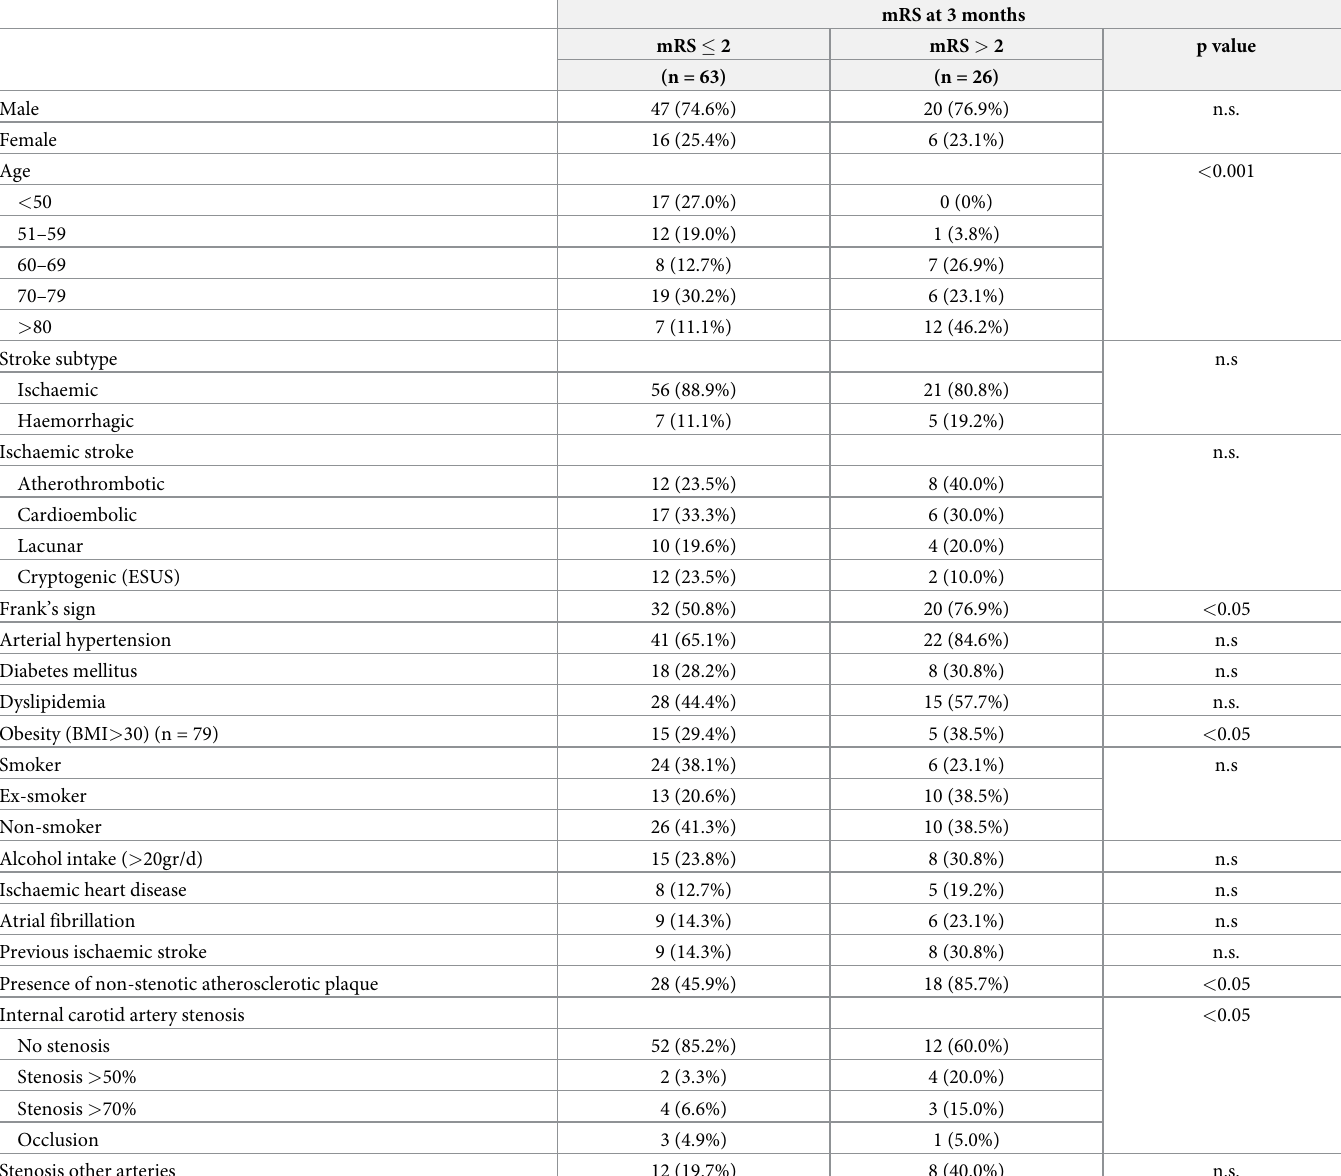
Table 3. Bivariate analysis of modified Rankin Scale at 3 months by baseline clinical variables included in the